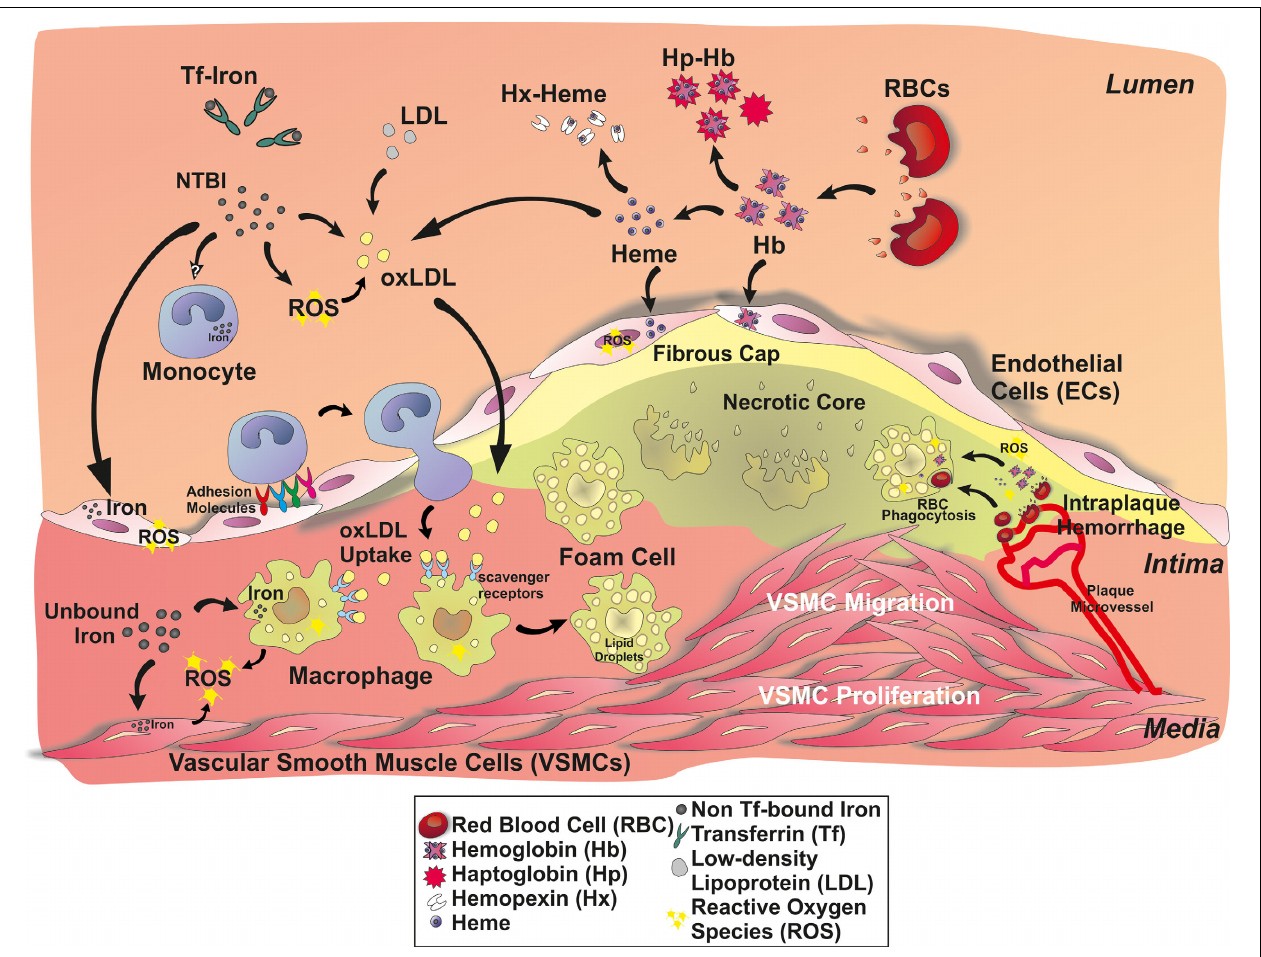
FIGURE 1 | A role for iron in atherosclerotic lesions. Iron accumulates in the plaque either as inorganic or hemoglobin-bound iron. Inorganic iron in part derives from circulating transferrin (Tf)-bound iron and non-transferrin-bound iron (NTBI). NTBI is generated in chronic iron overload conditions, such as in iron-loading anemia, hereditary hemochromatosis or secondary hemochromatosis due to blood transfusions. Circulating NTBI is accessible to many cell types in the atherosclerotic plaque: endothelial cells, monocytes/macrophages, and vascular smooth muscle cells (VSMCs).